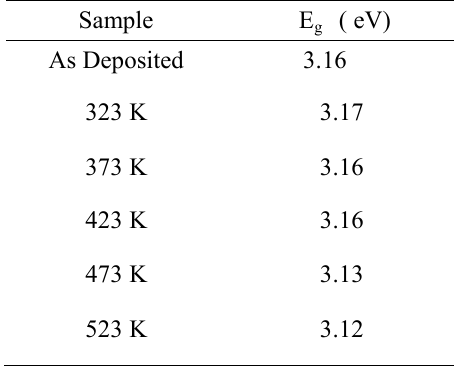
PcOC as deposited thin film and films annealed at different 2 8